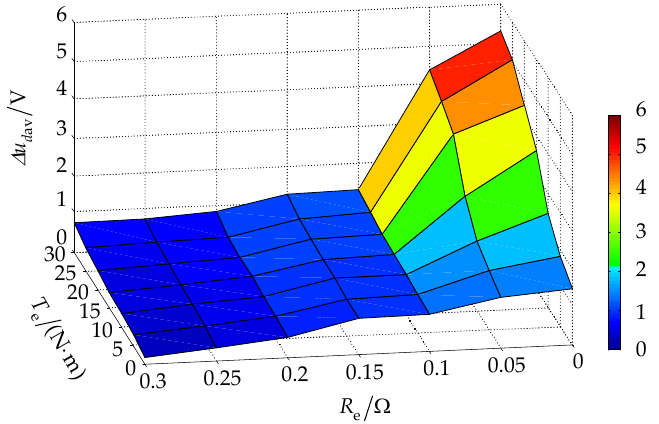
Figure 16. The variation diagram of ∆ u d av with the external contact resistance and the electromagnetic torque.